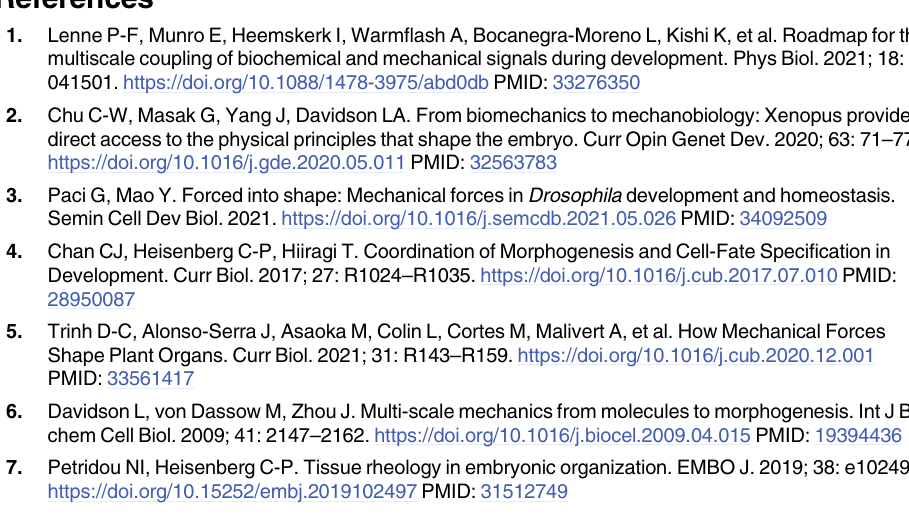
S4 Fig. Developmental changes in isotropy parameters in Drosophila epithelial tissues. (A– F) Estimated values of λ (A–C; the spring constant of junction) and k (D–F; the elastic modu- 1 lus of cells) at the stage indicated in the pupal wing (A, D), pupal notum (B, E), and embryo (C, F). The gray line connects the average estimated values of parameters for each stage. Dot colors represent a model selected by